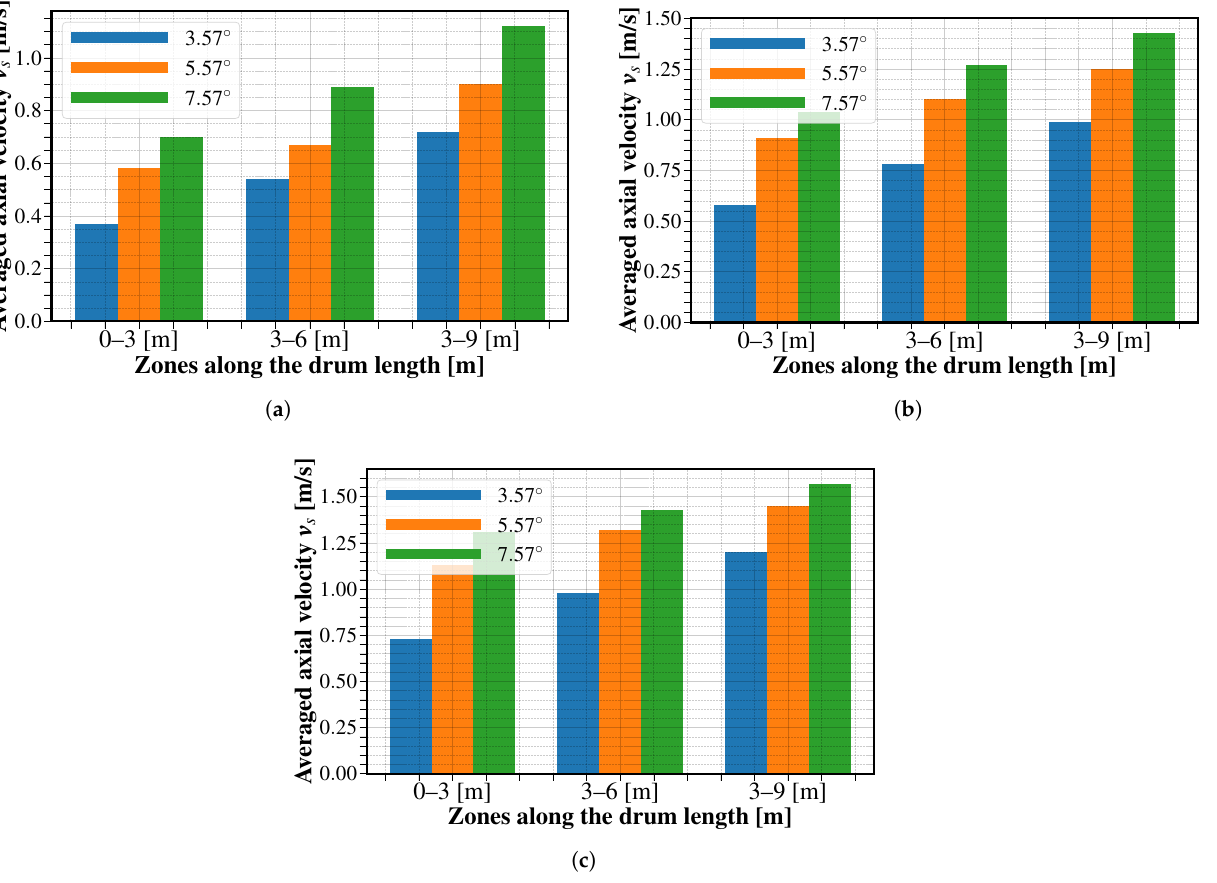
Figure 11. The axial particle velocity (m/s) distributions in three subdivision zones per drum length (m) for 8, 16, and 24 rpm rotational speeds. ( a ) 8 rpm. ( b ) 16 rpm. ( c ) 24 rpm. On the other hand, the effect of the inclination degree on particle dynamics is varying along the drum length. By increasing the inclination slope, particles tend to occupy the lower end of the drum, due to the gravitational force component in the axial